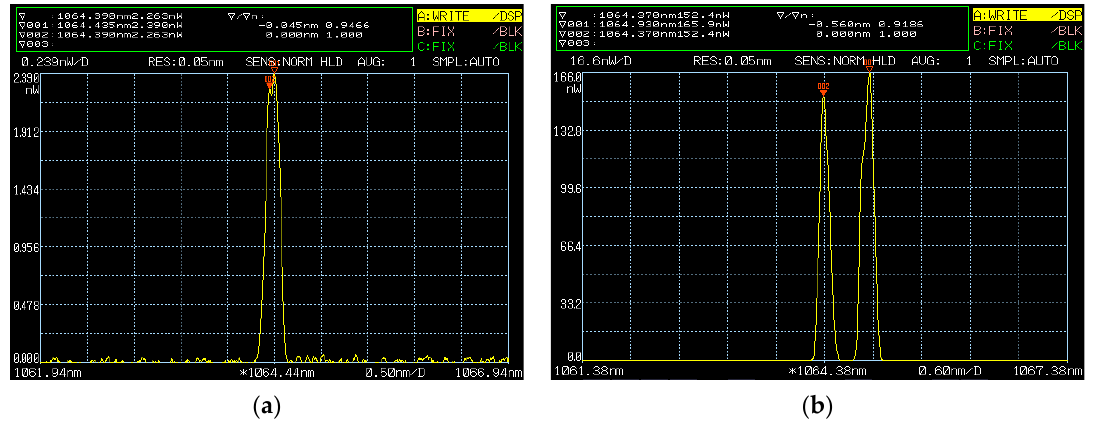
Figure 27. Oscillating spectra of dual-frequency laser with different frequency differences of ( a ) 11.9 GHz and ( b ) 148.4 GHz [35].